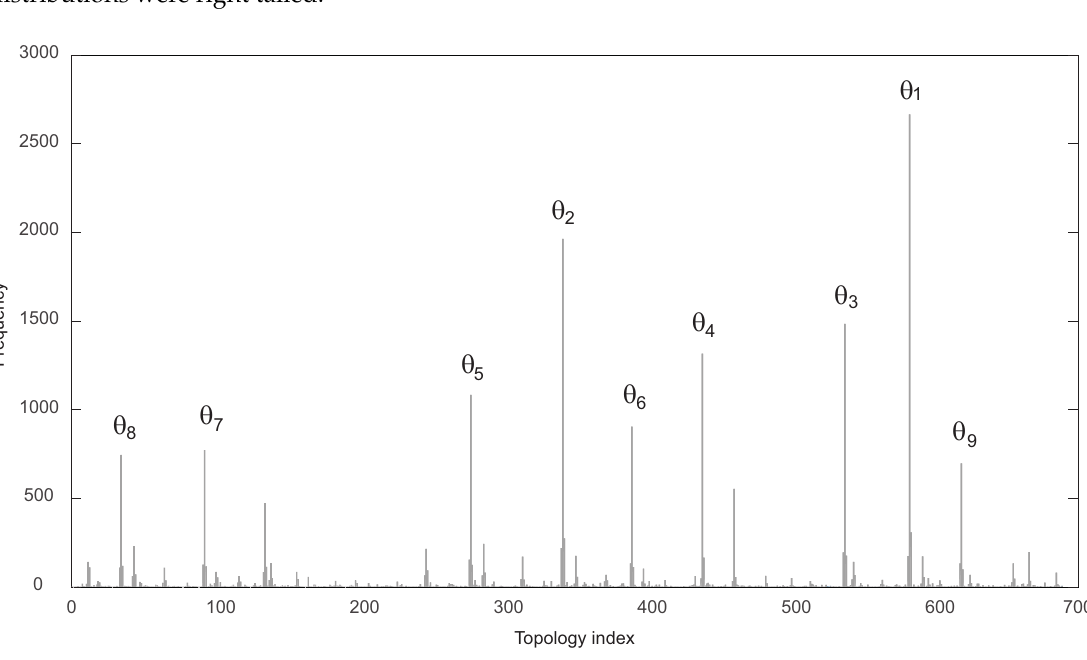
Figure 3. Frequency of each of the 689 functional topologies found by the